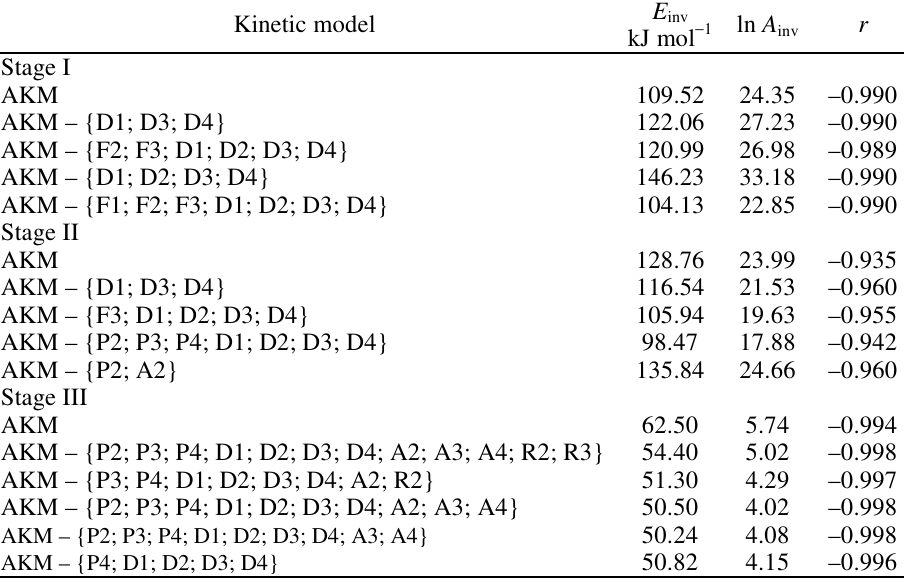
Table 6. IKP for several combinations of kinetic models for